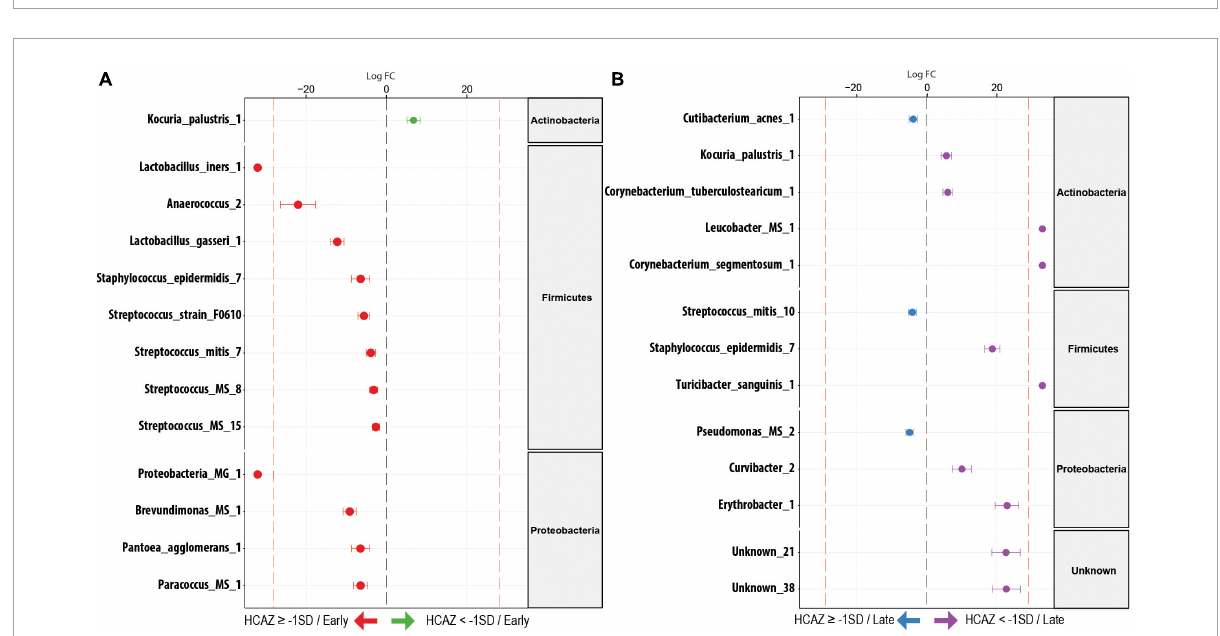
FIGURE5 Differentially abundant (DA) ESV associated to head-circumference-for-age-z-score (HCAZ). (A) Early lactation: 12 ESVs were significantly more abundant in HCAZ ≥ − 1 SD ( n = 18; left side) and 1 ESV in HCAZ < − 1 SD ( n = 11; right side). (B) Late lactation: 3 ESVs significantly more abundant in HCAZ ≥ − 1 SD ( n = 14; left side) and 10 ESVs in HCAZ < − 1 SD ( n = 19; right side). Species are colored and grouped by phylum. The dashed red line represents a limit beyond which ESVs were only quantified in a single group.